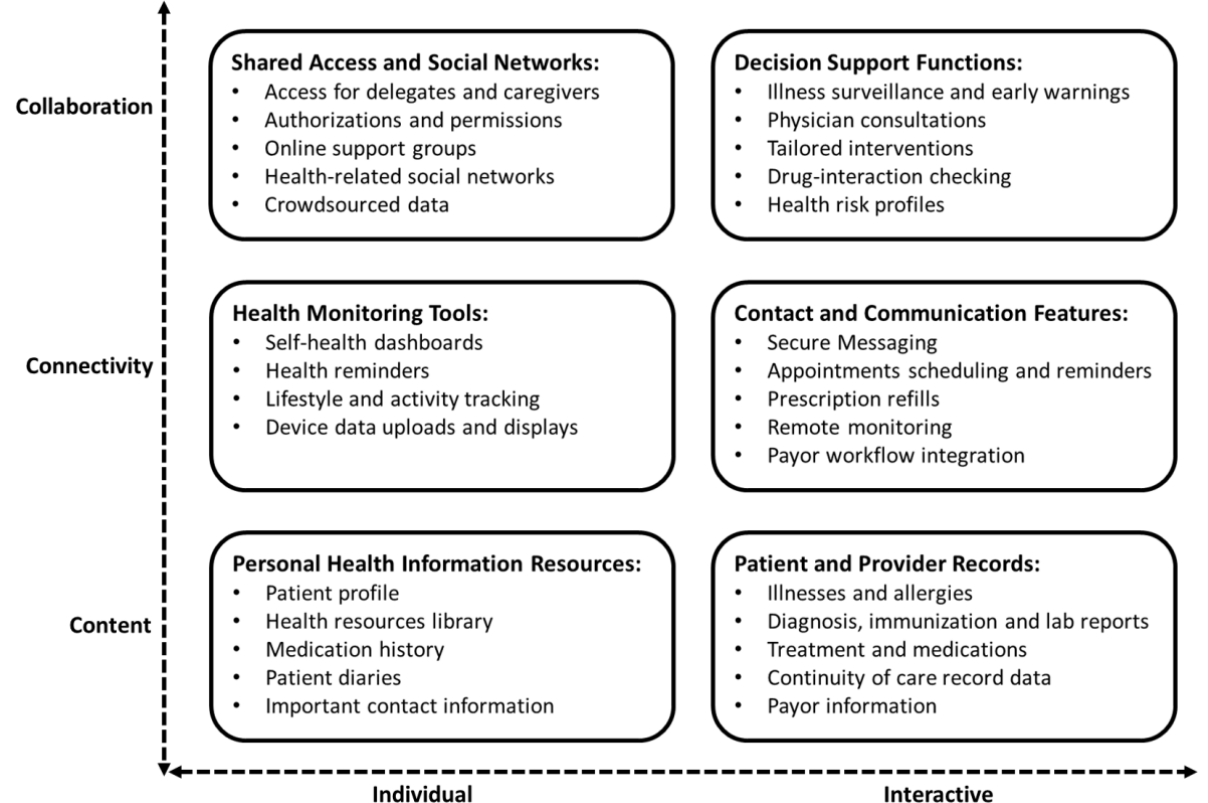
Figure 1. A high-level functional utility model of personal health record